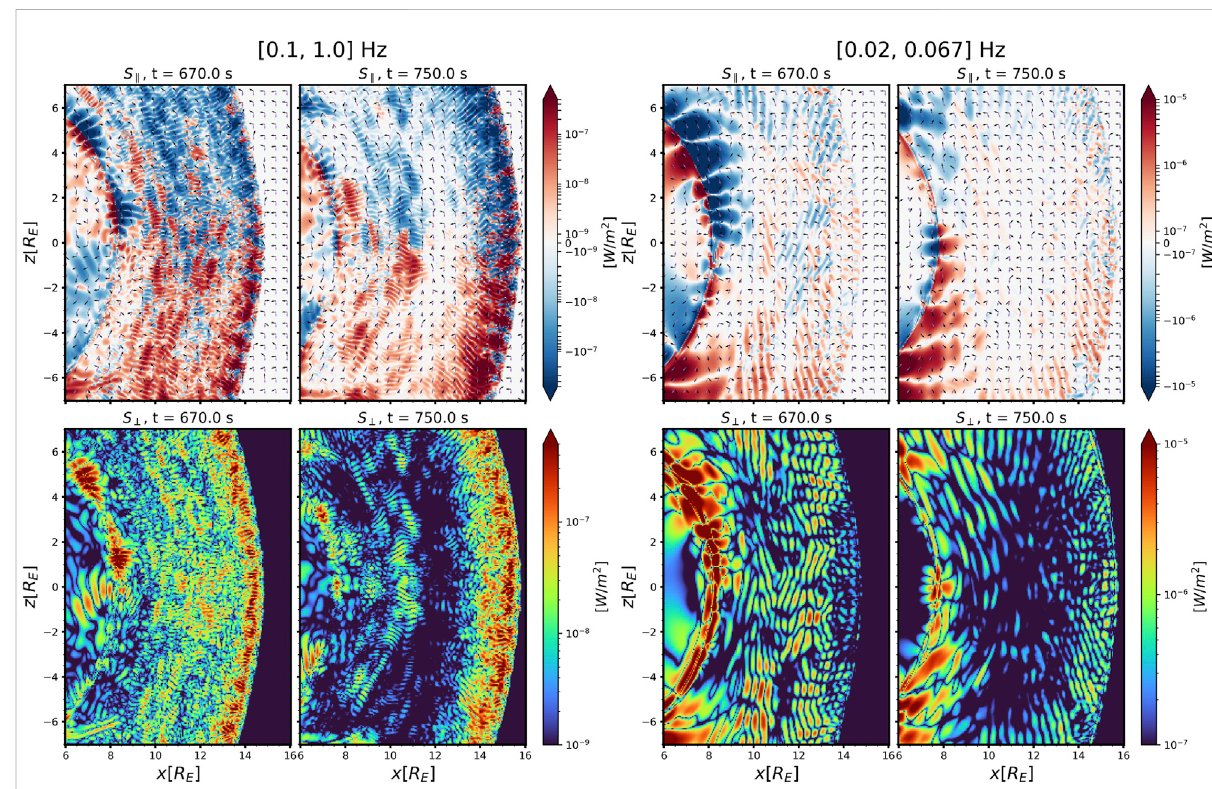
FIGURE 5 Perturbation Poynting vectors parallel ( fi rst row) andperpendicular (secondrow) to themagnetic fi eldinthesimulationplane. The leftand right four panels show band-pass fi ltered vector magnitudes between [0.1, 1.0] Hz and [0.02, 0.067] Hz respectively. The fi rst and third columns show t = 670 s,and thesecondand forthcolumnsshow t=750 s.The blackquivers denotethedirection ofin-plane Poynting vectors,andthepurple quivers denote the direction of in-plane ambient magnetic fi elds. Symmetric log scales with linear thresholds at 10 – 9 and 10 – 7 W/m 2 are used for S (cid:1) in the two bands, respectively. The arrows in the colorbars represent saturated colors with magnitudes that are equal or larger than the chosen